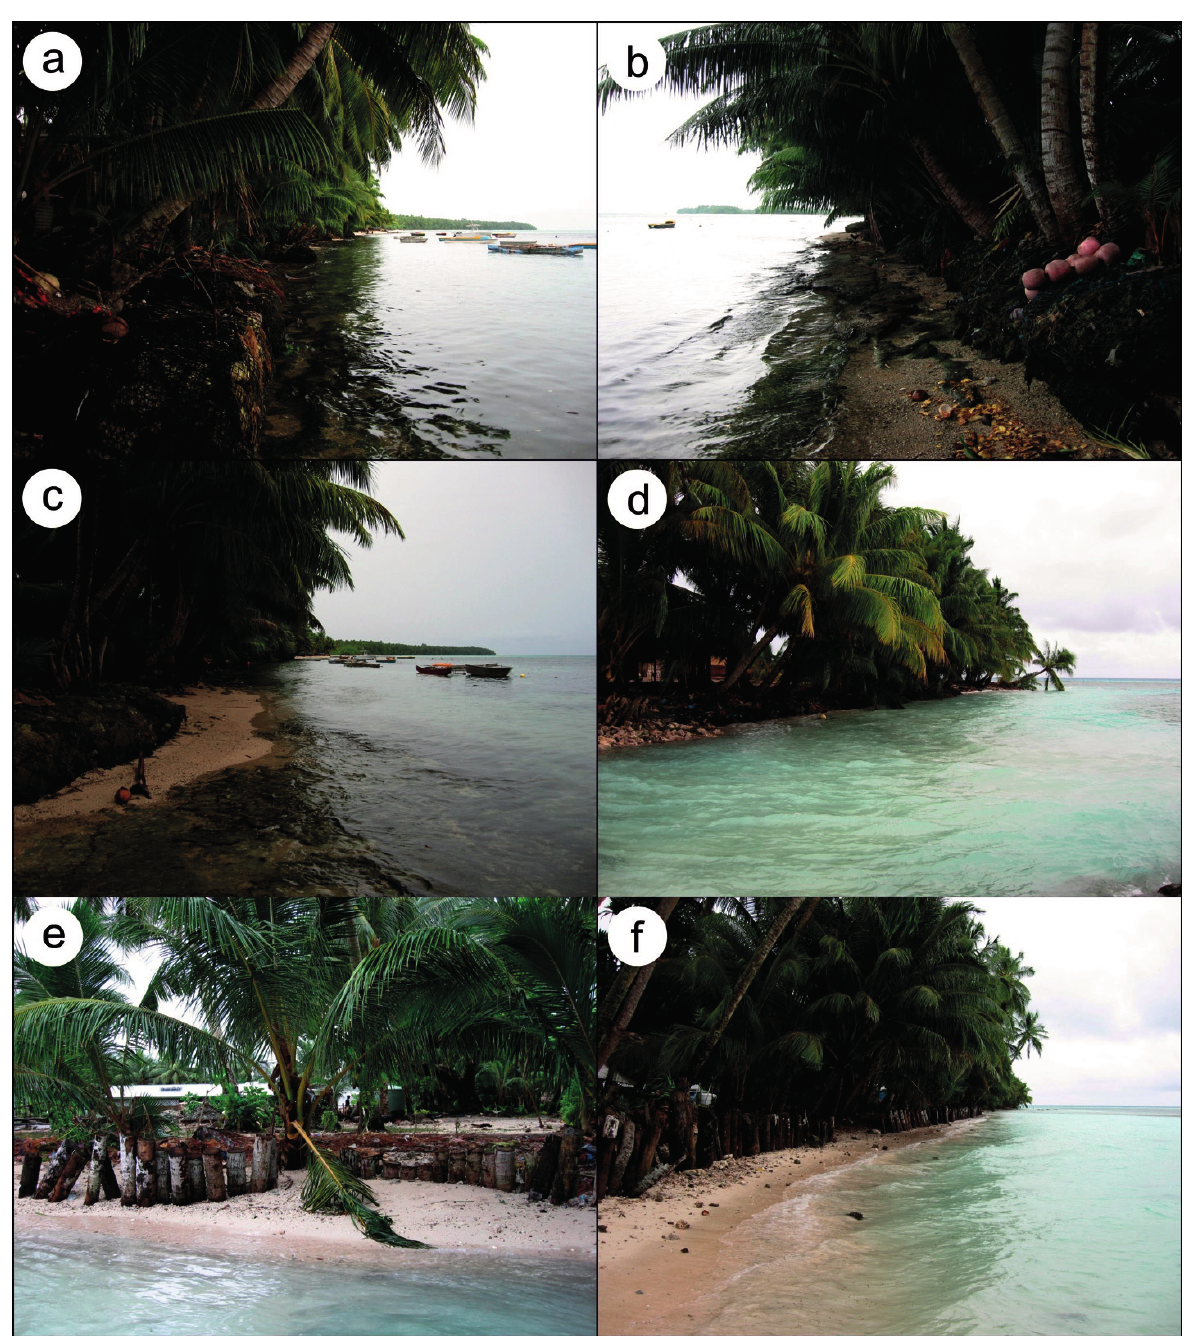
Figure 2. Pictures from seawalls on Nukutoa Island. ( a – d ) Traditional “rocks in net” walls (Gabion baskets). ( e , f ) Seawalls made of coconut logs. Pictures were taken in November and December 2008 and indicate that beach erosion prevails in front of the Gabion baskets. Photos courtesy of John R.